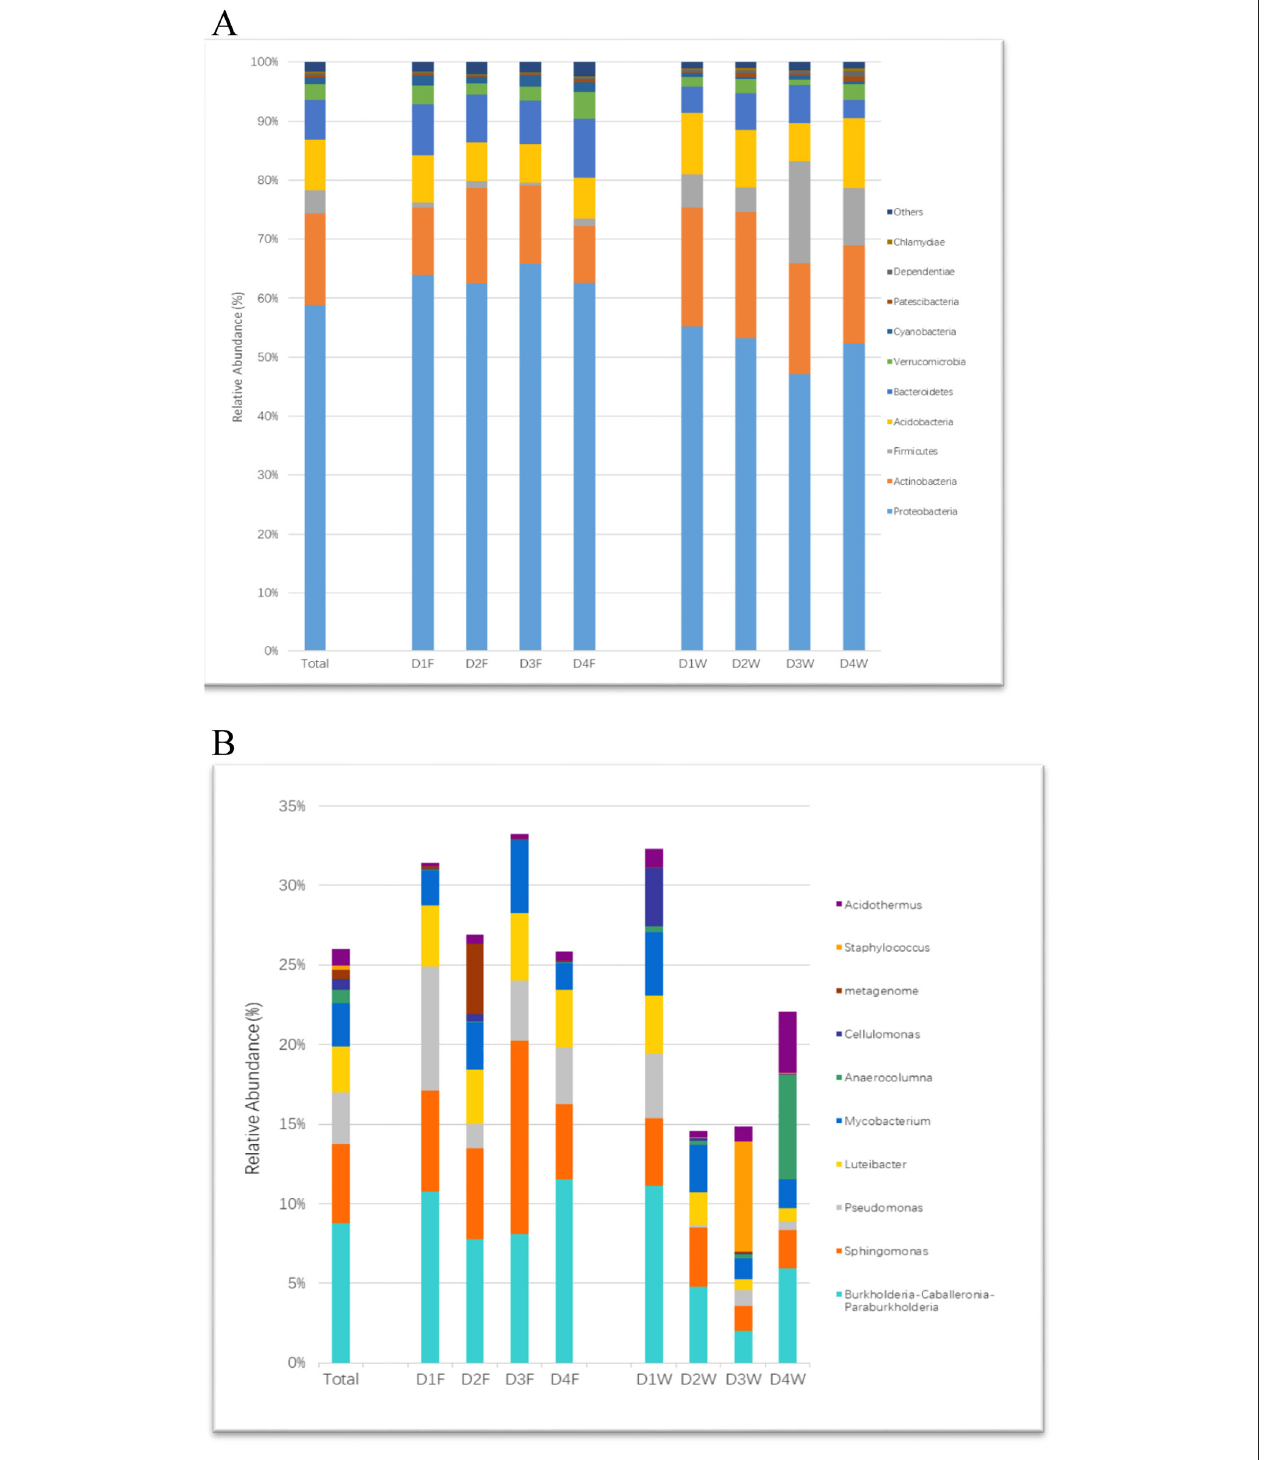
FIGURE 4 | The relative abundance of bacterial community at different taxonomic levels in study groups. (A) Phylum and (B) genus.